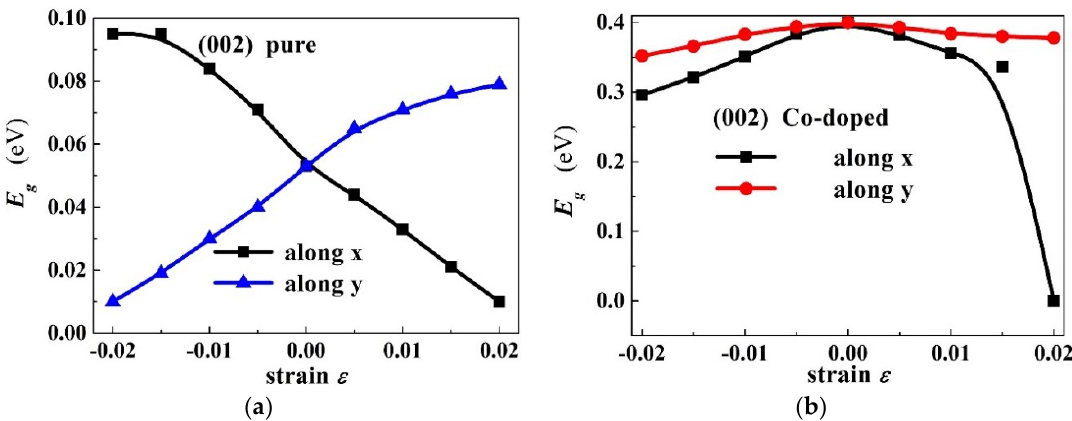
Figure 5. Band gap E g as a function of strain for ( a ) PbPdO 2 , and ( b ) PbPd 0.75 Co 0.25 O 2 along x-axis (called x) and b-axis (called y).